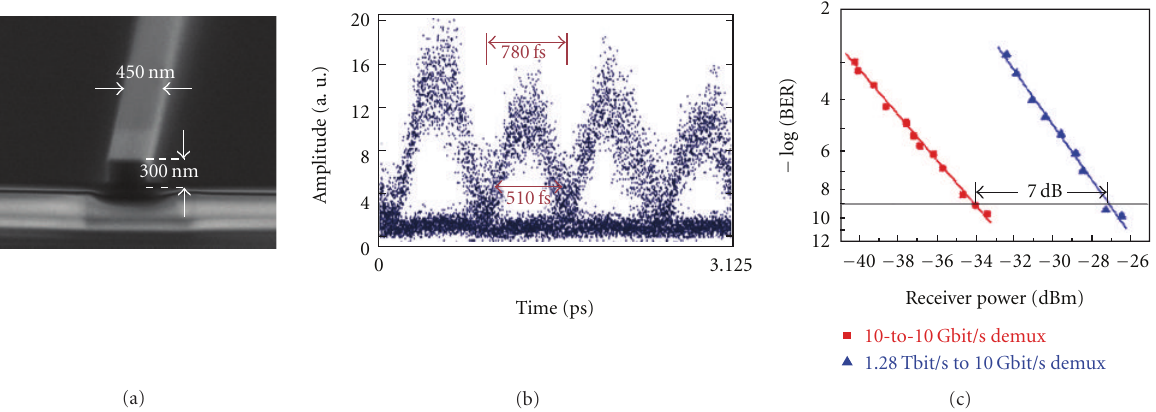
Figure 19: Ultra-fast silicon photonics. Using four-wave mixing in a silicon nanowire (a) is demonstrated to perform Tbit/s optical signal processing by sampling a 1.28Tbit/s serial data signal (b) and error-free demultiplexing